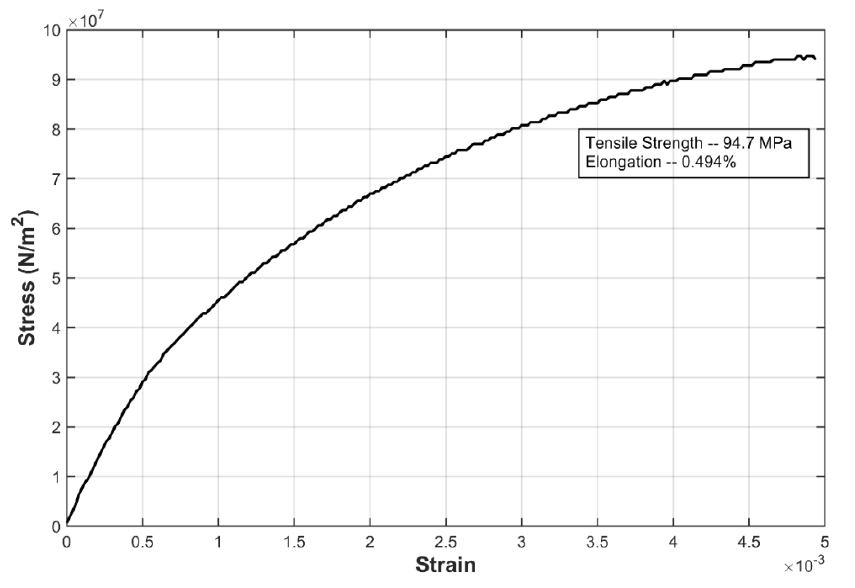
Fig. 5. Typical stress-strain curve of the Al-alloy/Mg-alloy/Al-alloy